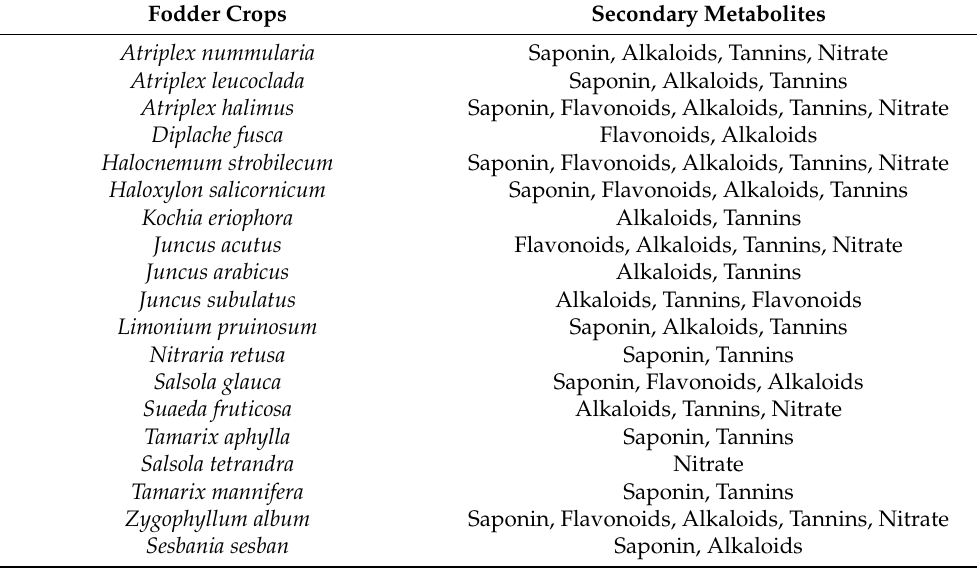
Figure 2. Metabolomics analysis in plants exposed to engineered nanomaterials. Table 1. List of plant species and their secondary metabolites